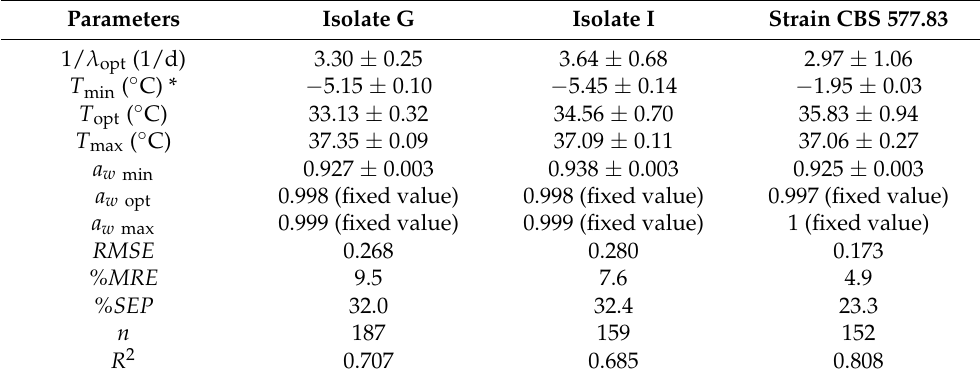
Table 1. Estimated cardinal model (CM) parameters and statistical indices for lag time modelling of G. candidum against temperature and a w .